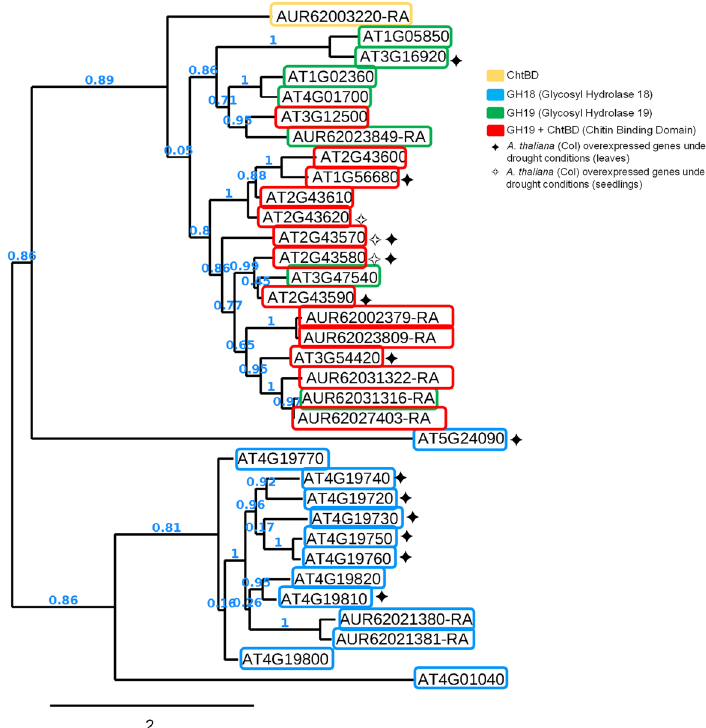
Figure 6. Phylogenetic tree of A. thaliana chitinases and quinoa chitinase-related proteins found in seeds under rainfed condition. Twenty-five chitinases have been identified in A. thaliana which are mainly divided into three groups based on their catalytic and binding domains. The 9 chitinase-like proteins differentially abundant under rainfed conditions in the quinoa seeds analyzed, showed sequence similarities to protein domains of A. thaliana ones. In addition, quinoa chitinase-like proteins were closer to the ones that were highly expressed in microarray data from leaves and seedlings of A. thaliana grown under drought conditions from two independent experiments summarized in 29